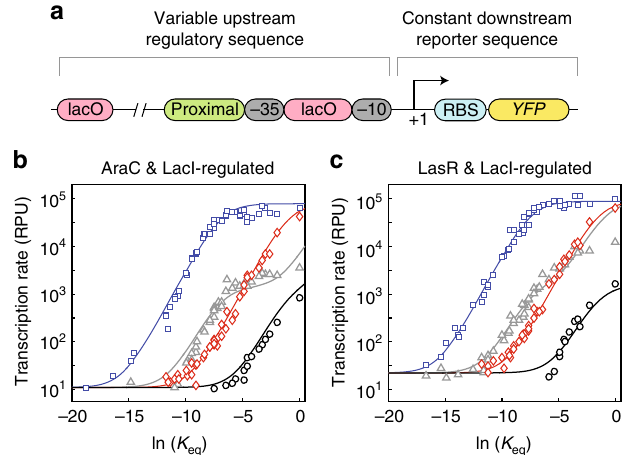
Fig. 4 Hybrid promoters are tunable. a Diagram of the hybrid promoters showing essential features. Each promoter contained a proximal operator site for either AraC or LasR, the − 10 and − 35 sites from the library shown in Fig. 2, the constant reporter sequence, and two operator sites for the transcriptional repressor LacI. b Transcription rate of the AraC- and LacI- regulated hybrid promoters as a function of the relative equilibrium constant of σ -factor binding to the − 10 and − 35 sites for four different conditions: neither inducer (black), only arabinose (gray), only IPTG (red), and both arabinose and IPTG (blue). The thermodynamic model (solid curves) was fi t to the results of each combination of the − 10 and − 35 sites. c Same as b , but for the LasR- and LacI-regulated hybrid promoters and with 3OH-C12-HSL instead of arabinose. Experiments were performed with biological triplicates. Error bars have been omitted for clarity as they are, in most cases, smaller than the size of the symbols. Thermodynamic modeling data and experimental data are available in Supplementary Information and Supplementary Data inducibility depending on the free energy of σ 70 binding, as shown in the induction curves for three different combinations of − 10 and − 35 sites (bD, dE, and eG) in the AraC- (Fig. 3c) and LasR-regulated (Fig. 3f) promoters.